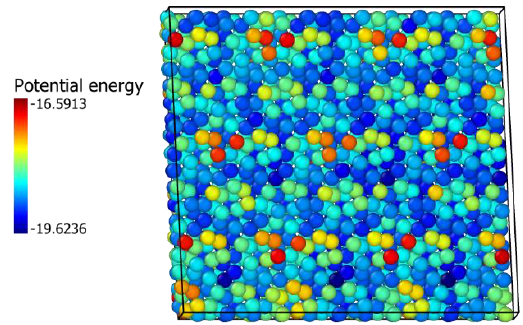
Figure 8. In 2 O 3 (111) over ZrO 2 (111) physical mixture. ZrO 2 oxygen atoms potential energy at the interface (eV).